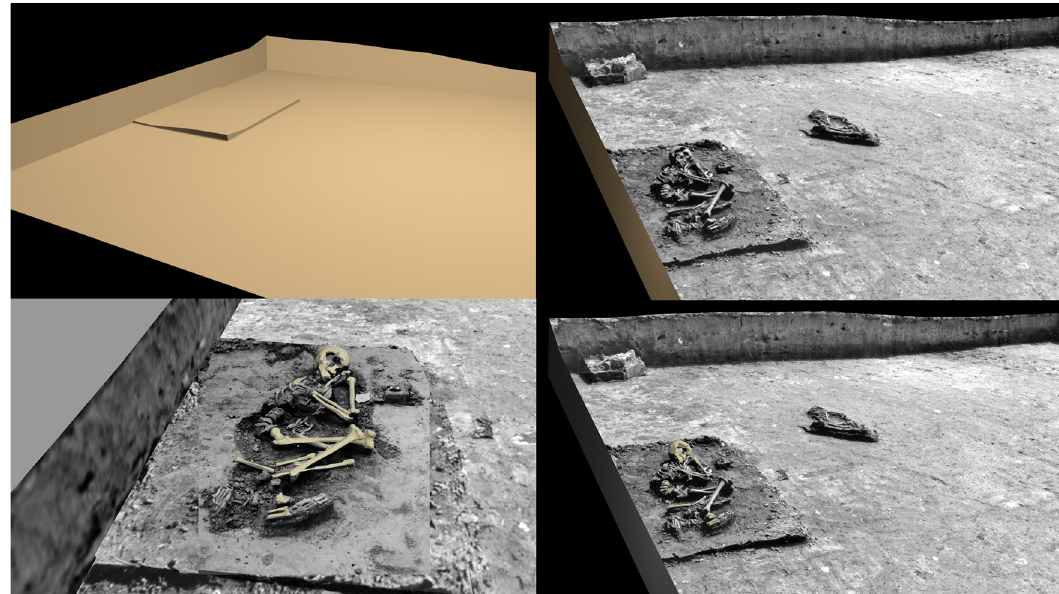
Figure 6: Top left: low polygon model of the excavation unit created in Cinema 4D. Top right: projection of image on 3D model, once correct position and perspective of camera have been obtained. Bottom right: placing the digital replicas of the bones in position from this particular projection camera. Bottom left: placing the digital replicas of the bones in position by using another image/angle in the projection